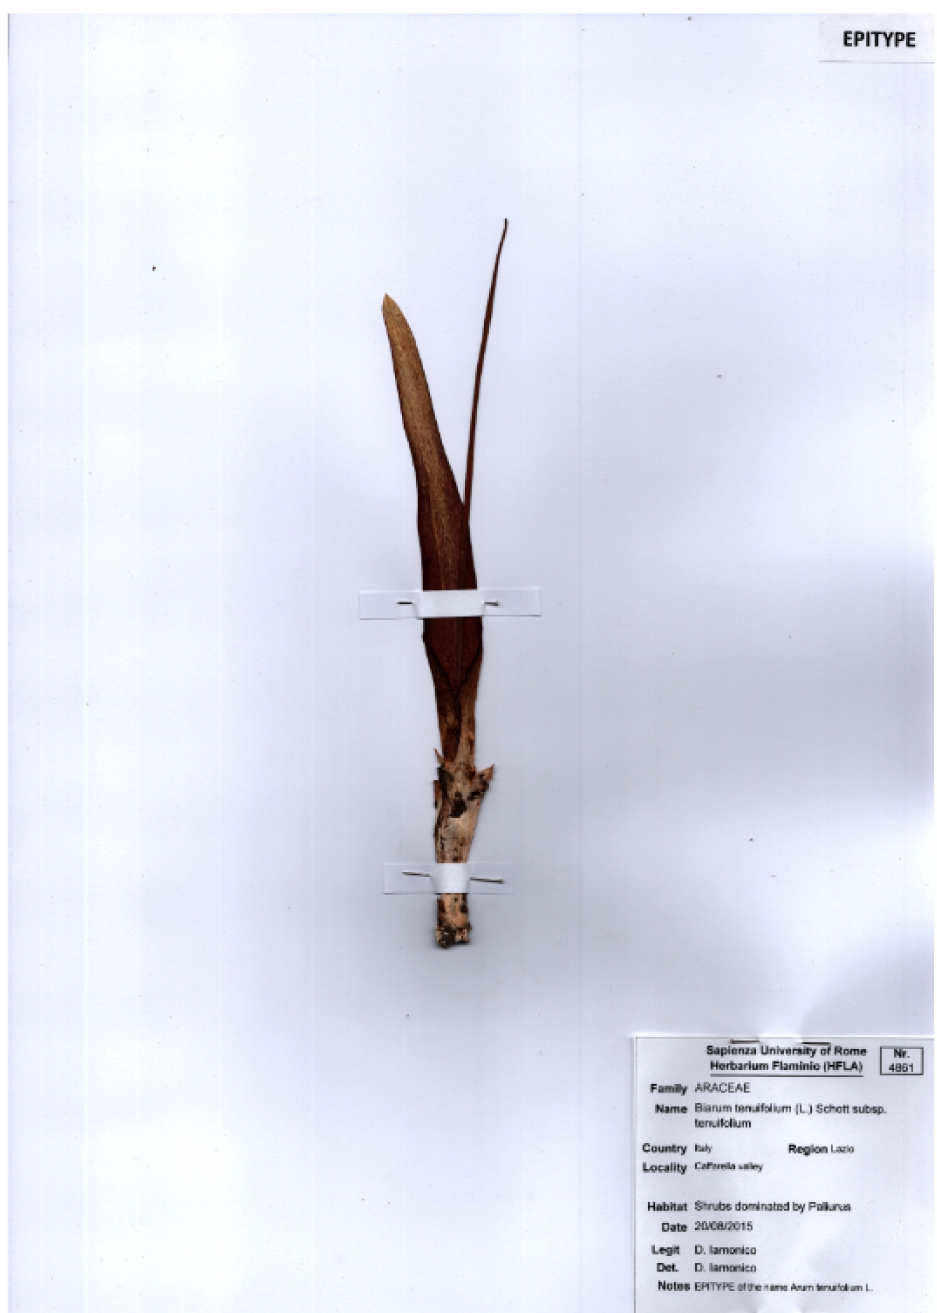
Figure 71. Epitype of Biarum tenuifolium subsp. tenuifolium (HFLA no.